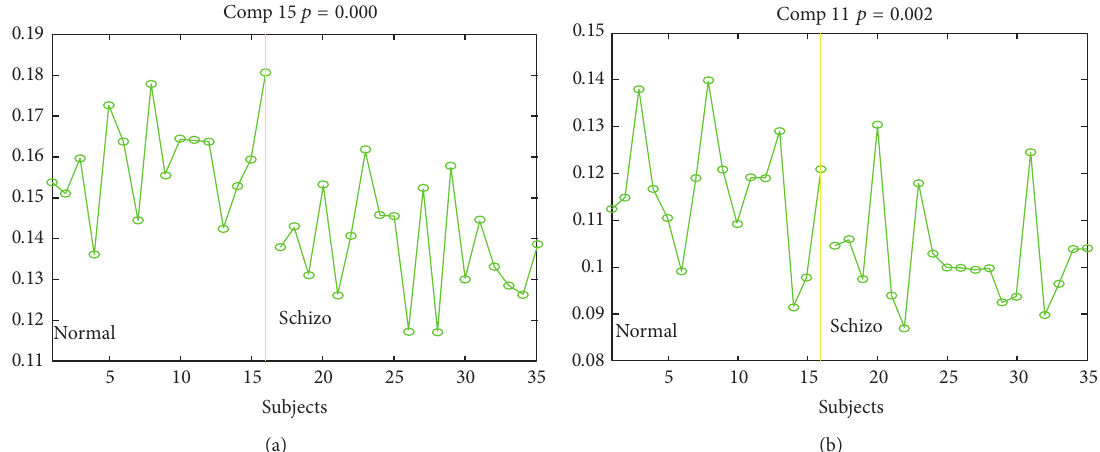
Figure 2: Loading parameters of Component 15 (a) and Component 11 (b). The most significant loading parameter for the 𝑝 scale. Dividing into two groups: normal (the right of the yellow line) and schizophrenia (the left of the yellow line).